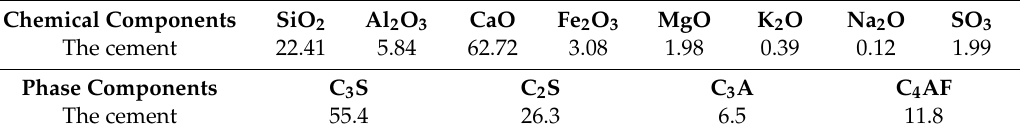
Table 1. Chemical and phase analysis of the cement (wt.%).